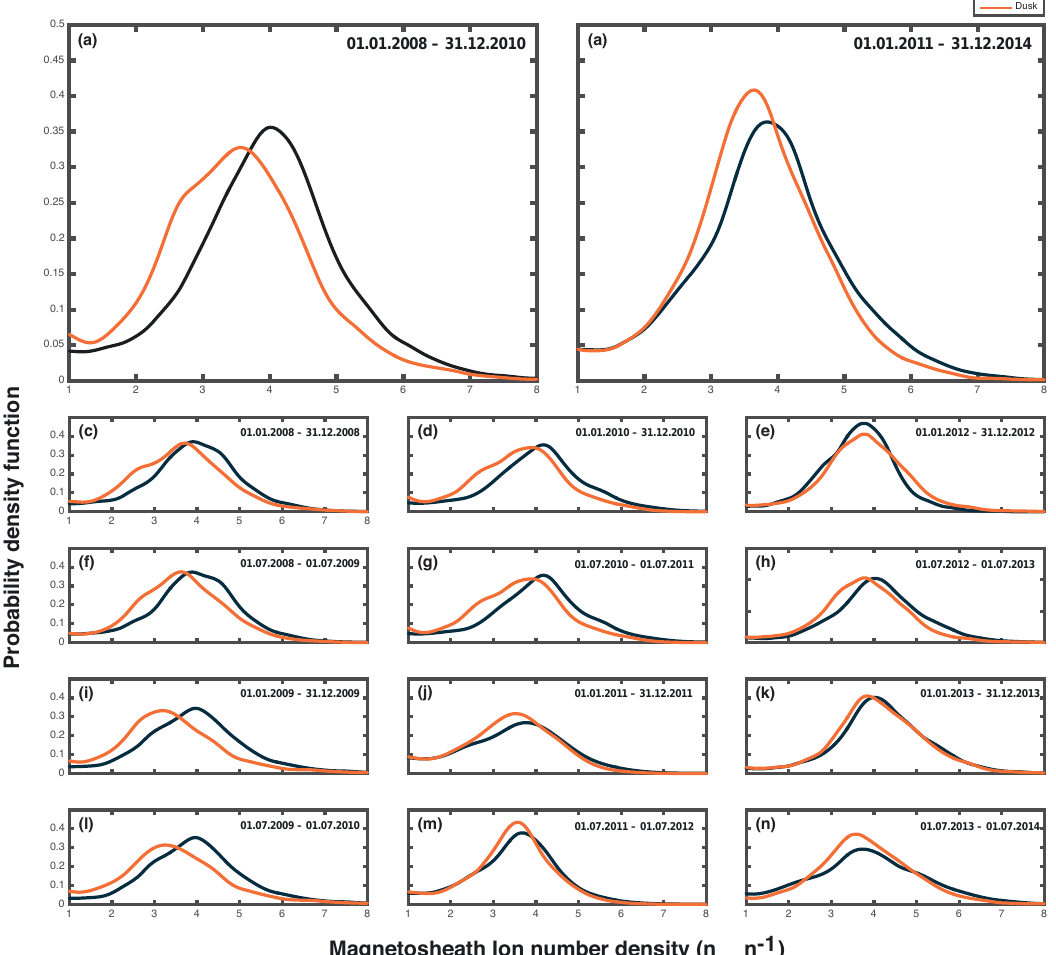
Figure 5. Probability density functions of the magnetosheath ion number densities normalised by their corresponding solar wind values. In all panels the solid black line corresponds to the dawn flank whereas the dashed red line indicates the dusk-side. Panels (a) and (b) correspond to longer intervals surrounding and following the 2009 solar minimum. The remaining panels (c–n) correspond to the distributions of 1-year intervals from January 2008 incremented by 6months until July 2014. The intervals for each distribution in panels (c–n) are labelled in the top right of each panel. Panels (c–n) are plotted on identical x and y scales.